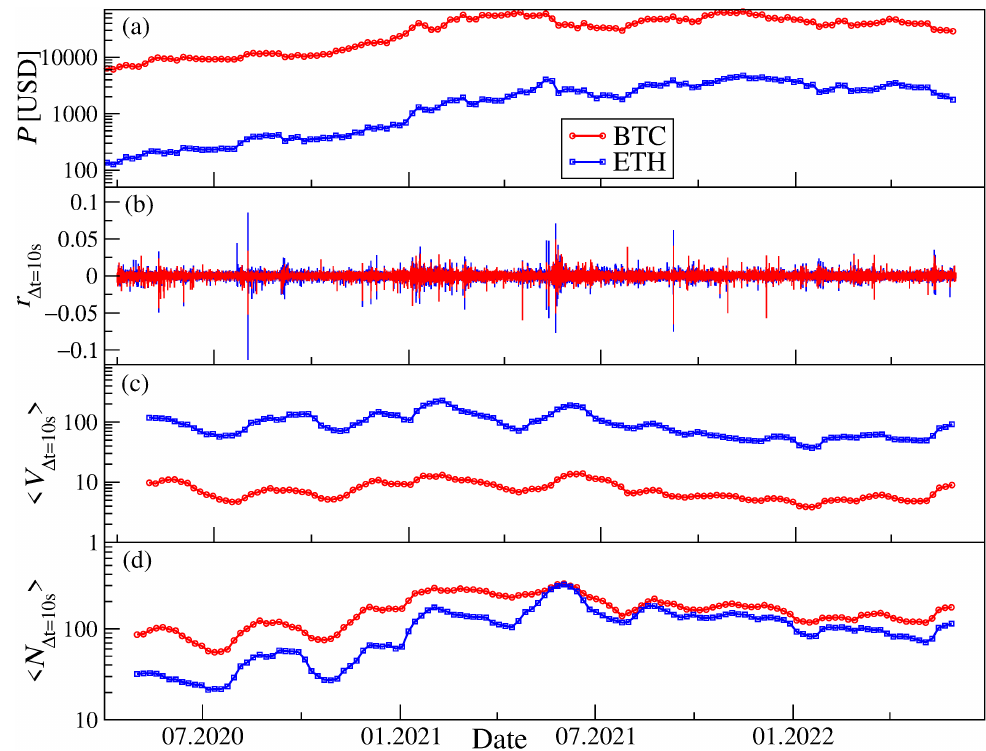
Figure 1. Evolution of the quantities of interest over the time period considered in this study for two principal cryptocurrencies: BTC (red circles) and ETH (blue squares). ( a ) Price P ( t ) of the cryptocurrencies expressed in US dollars; ( b ) logarithmic returns r ∆ t ( t ) for ∆ t = 10 s; ( c ) mean volume traded (cid:104) V ∆ t ( t ) (cid:105) in 10 s intervals; ( d ) mean number of transactions (cid:104) N ∆ t ( t ) (cid:105) in ∆ t = 10 s. The averaging was carried out over a rolling window of 1 month with a step of 6